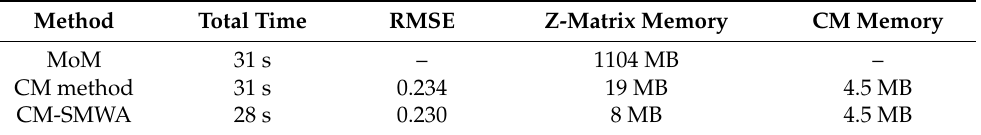
Table 3. Comparison of the calculation time and memory of the different algorithms for the cylinder. Method Total Time RMSE Z-Matrix